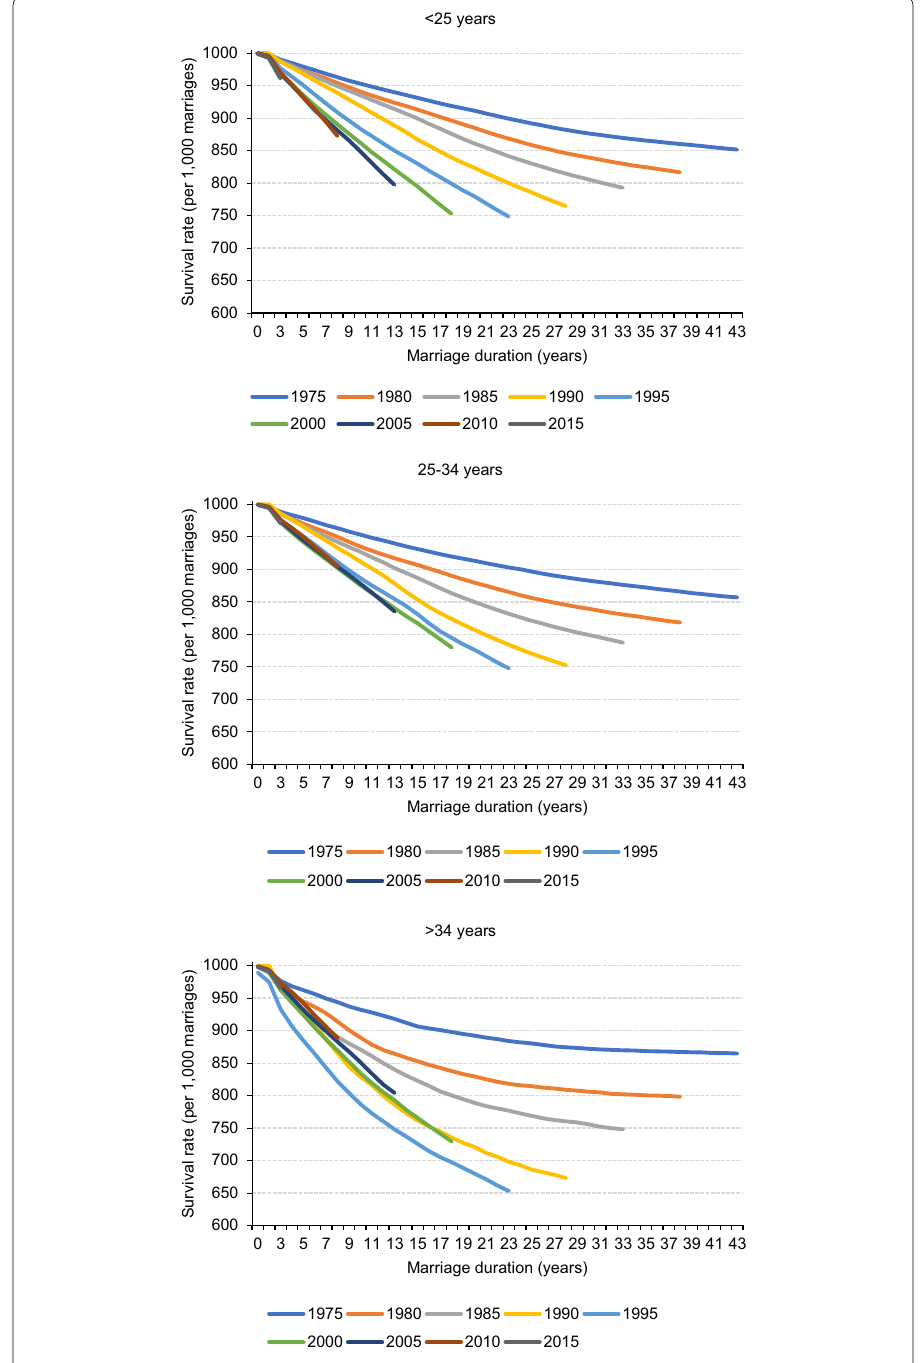
Fig. 4 First marriages surviving at separation by duration of marriage, marriage cohort, and female age at marriage (survival rates per 1000 marriages), Italy. Source Author’s elaboration of Istat data on marriages and